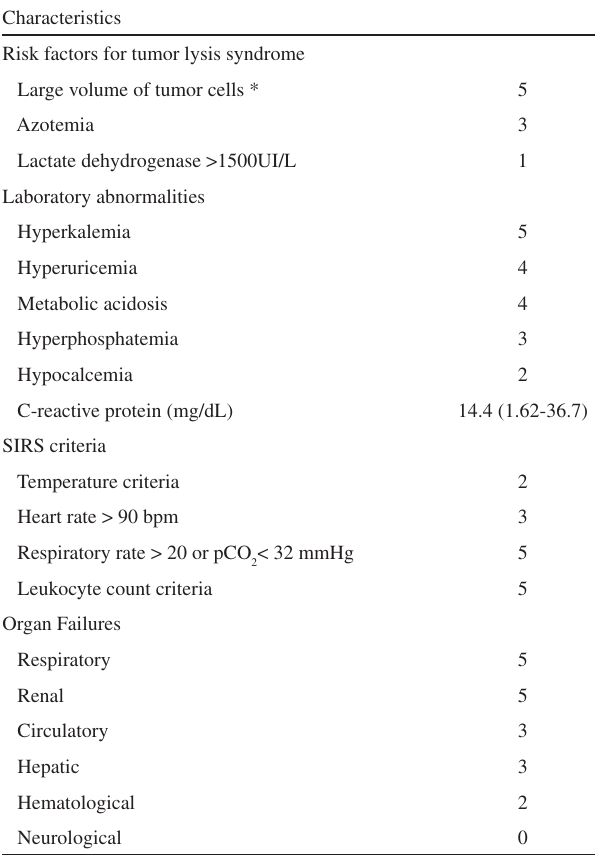
Table 1 - Main clinical characteristics and laboratory abnor- malities (n=5)